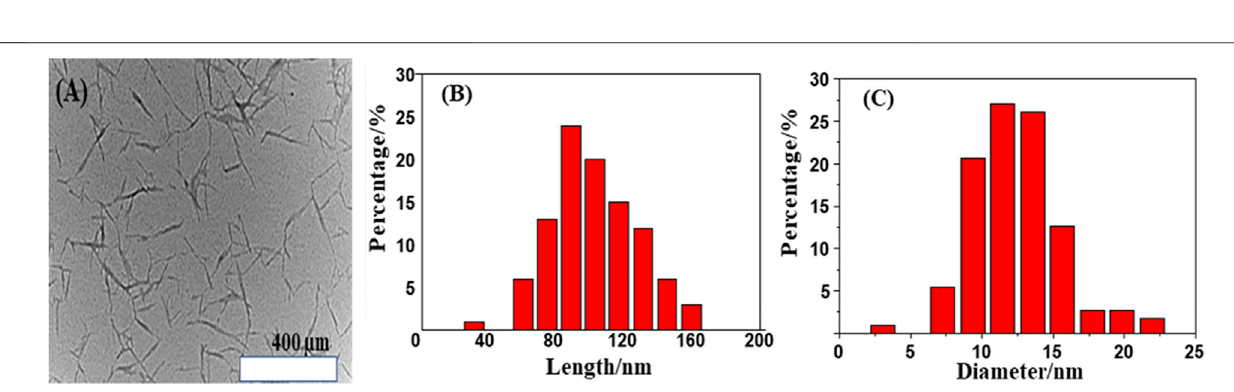
Frontiers in Bioengineering and Biotechnology |